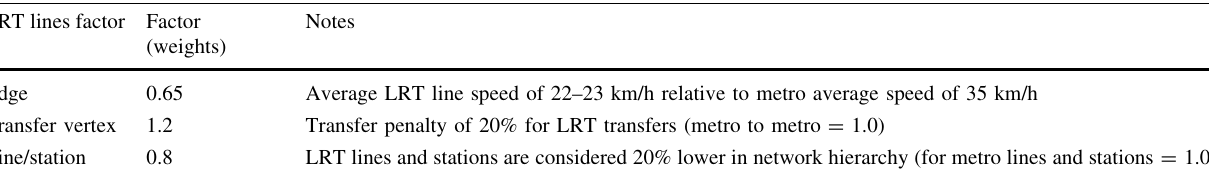
Table 2 LRT lines factors LRT lines factor Factor